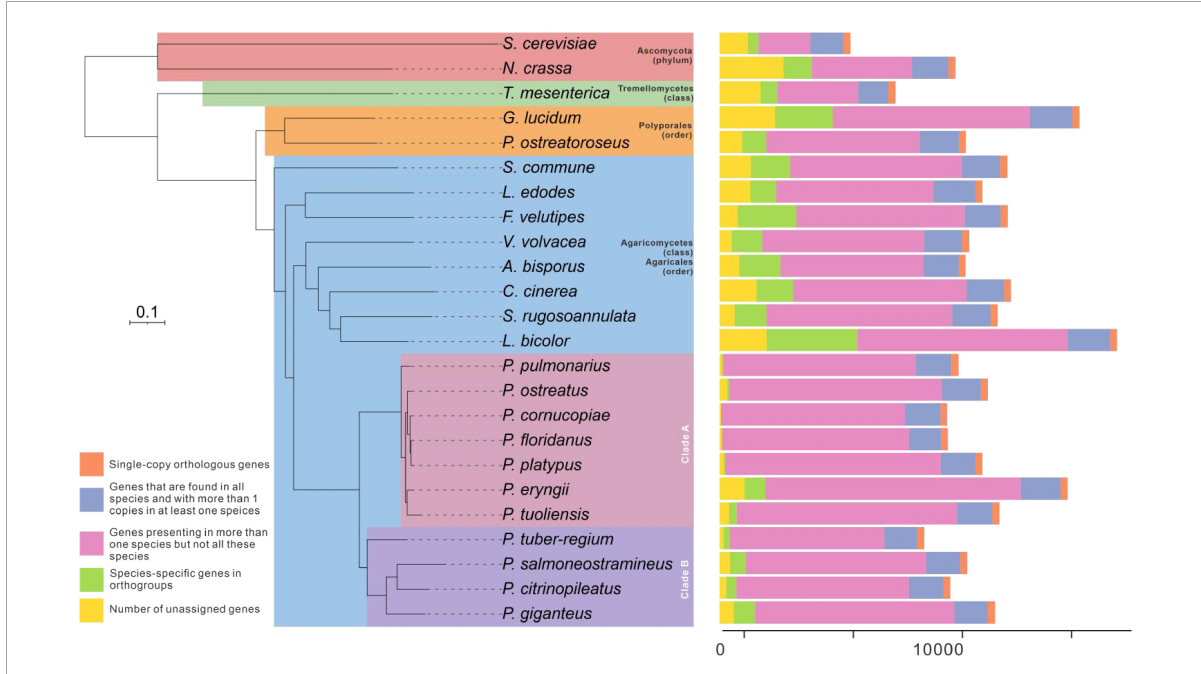
FIGURE3 Comparison of genomes between P. giganteus with other 23 fungal species (21 Basidiomycetes and 2 Ascomycetes). The evolutionary relationship analysis was constructed based on 312 single-copy orthologous gene. Tree scale =